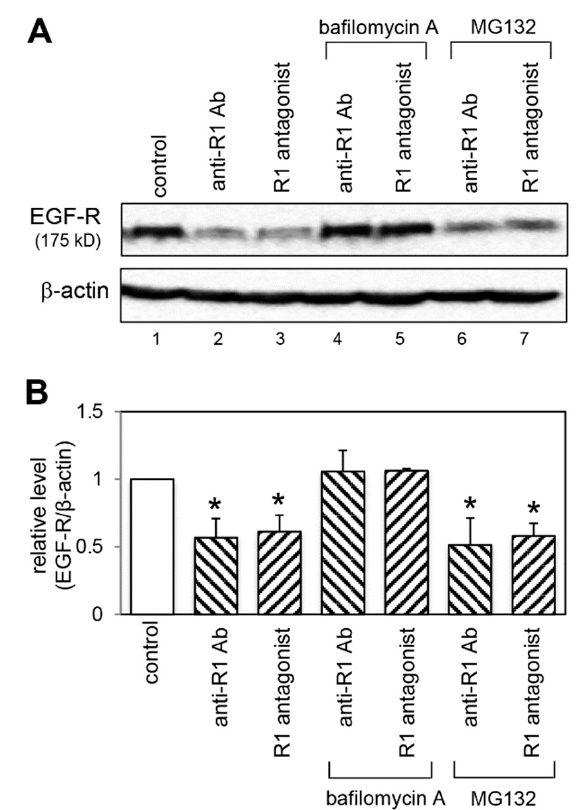
Figure 8. EGF-R downregulation is mediated by a lysosomal degradation pathway under VEGFR-1 inhibited conditions. ( A ) Cells were pretreated with a lysosomal inhibitor (bafilomycin A) or a proteasomal inhibitor (MG132) for 1 h, then treated with anti-R1 Ab (lanes 4 and 6) and R1 antagonist (lanes 5 and 7) for 1 h. Without bafilomycin A or MG132, cells were treated with anti-R1 Ab alone (lane 2), R1 antagonist alone (lane 3) or control IgG alone (lane 1, indicated by control) for 1 h. EGF-R protein levels were determined by immunoblot analysis. The levels of β -actin are shown as a loading control. ( B ) Quantification of EGF-R levels normalized to β -actin from three independent experiments. * p < 0.01, statistically significant decrease compared with the control.